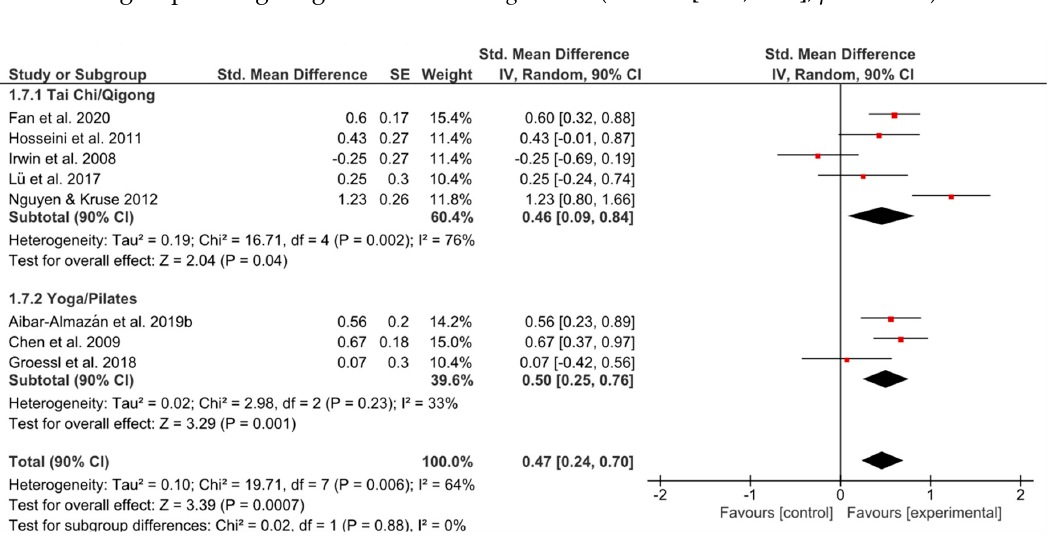
Figure 8. Standardized mean effects of mind–body interventions on sleep quality compared to a non-exercise control group. Data are separately presented for Tai Chi/Qigong and Yoga/Pilates. SE: standard error; IV: inverse variance model; CI: confidence interval; Std.: standardized.